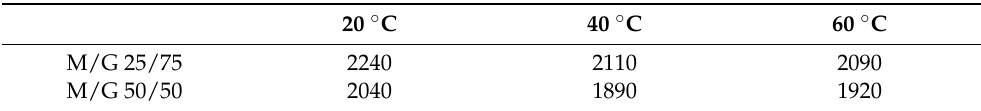
Table 4. The average density of geopolymers with different CRT glass contents and cured at different temperatures.